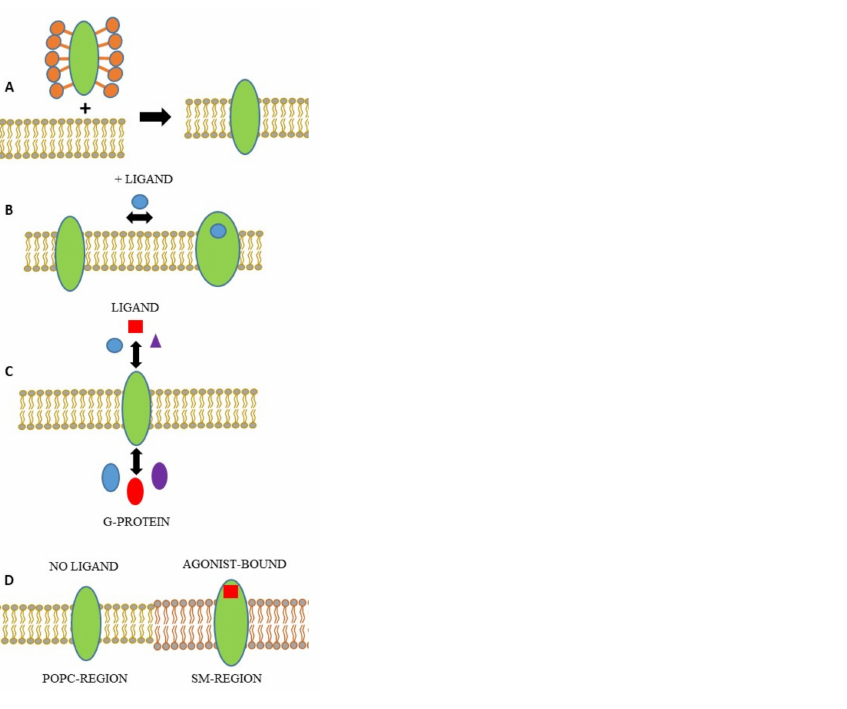
Figure 4. Representation of the different aspects of receptor activity that can be investigated by means of PWR. ( A ) Receptor reconstitution from detergent micelles into a lipid membrane. ( B ) Ligand- induced conformational changes of the receptor. ( C ) Ligand and effector interaction (G-protein in this case) with the receptor. The fact that different ligands can lead to the recruitment of specific G-protein subtypes is illustrated as represented by the color code. ( D ) Receptor distribution in different lipid domains, enriched in phosphatidylcholine (POPC) or sphingomyelin (SM) as a function of receptor